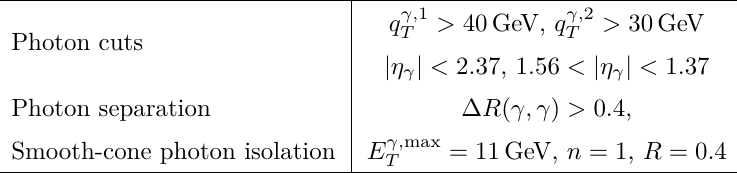
Table 5. Fiducial cuts in diphoton production at